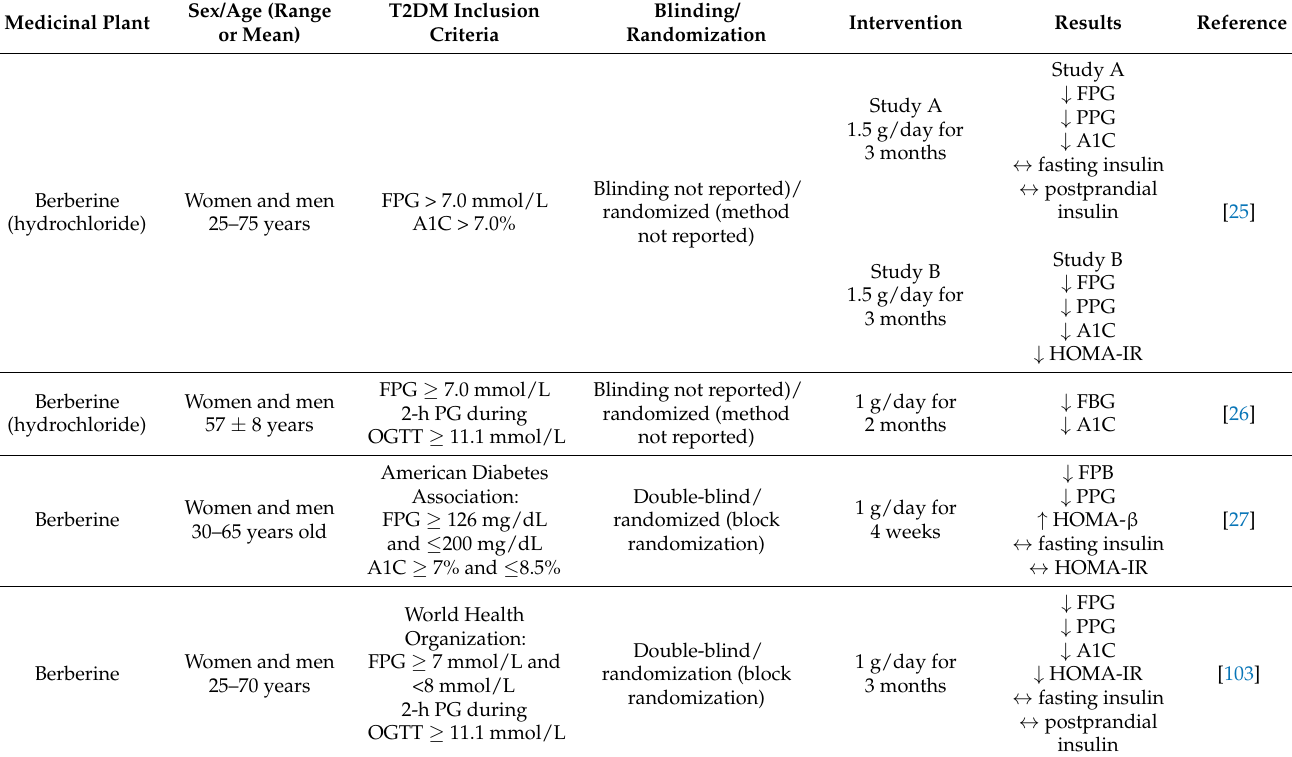
Table 4. Berberine: clinical evidence in type 2 diabetes